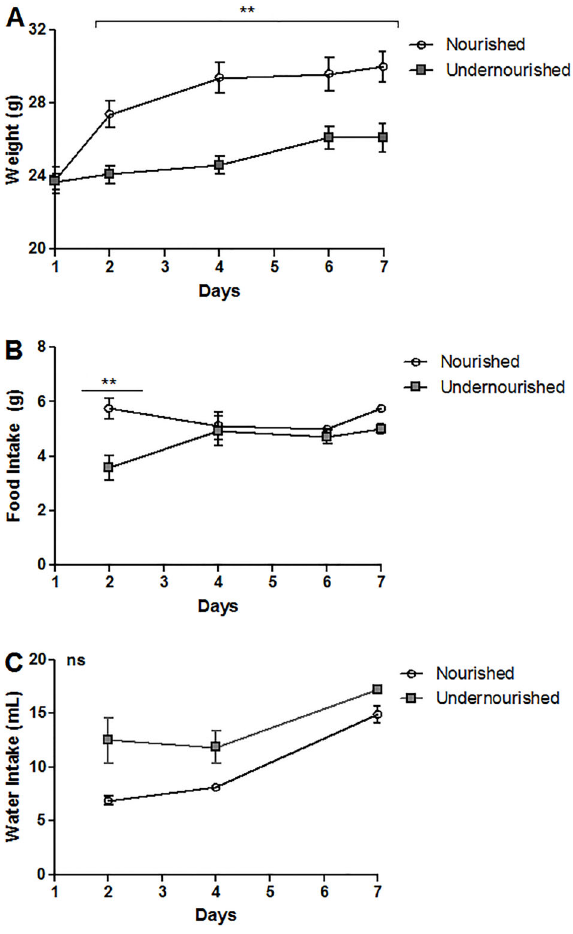
Figure 2. Weight curves from the regional basic diet (RBD) murine model of moderate acute undernutrition. The weight ( A ), food ( B ) and water ( C ) intake are shown after a 7-day challenge with the RBD. ns: non-signi fi cant. Data are reported as means ± SE (n=4). **P o 0.001 (ANOVA with the Bonferroni ’ s multiple comparison